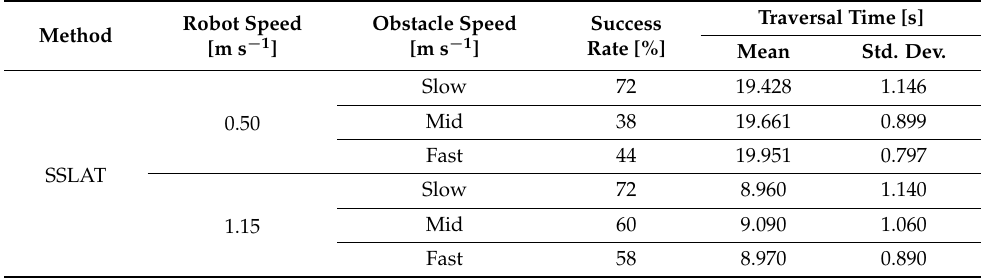
Table 2. Performance comparison of three motion planning strategies in the presence of moving obstacles, as shown in Figure 12. The speed of the obstacles is randomly sampled from the